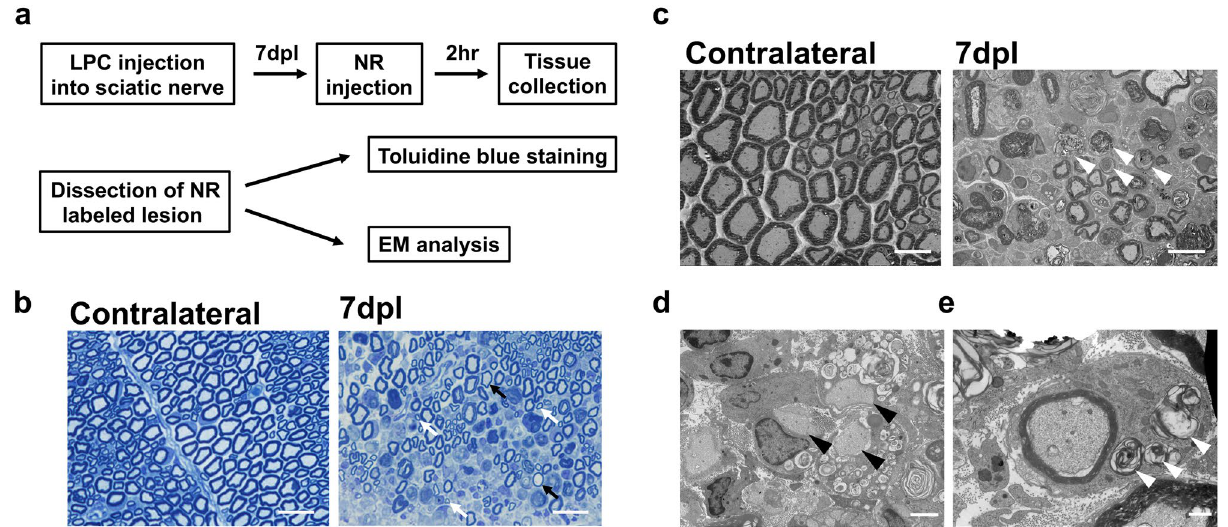
Figure 2. Electron microscopy (EM) analyses following the neutral red labeling. ( a ) Experimental design of EM analyses. Sciatic nerve lesions were induced by lysophosphatidylcholine (LPC) injection and labeled with neutral red (NR) injected 2 h before sacrifice at 7 dpl. Lesions labeled with NR were dissected and embedded in epoxy resin. Semithin sections were stained with toluidine blue. Ultrathin sections were observed by transmission EM. ( b ) Representative images of semithin sections (1 µm) obtained from contralateral and ipsilateral sciatic nerves of the LPC-injected mouse at 7 dpl and stained with toluidine blue. Compared to the contralateral nerve cross-sections, thinner compact myelin ( b , black arrows) and smaller axons ( b , white arrows) with myelin ensheathment were present in the LPC-treated nerve. ( c ) In the EM observation, contralateral axons have thick compact myelin, while myelin debris is observed in ipsilateral sciatic nerve at 7 dpl ( c , white arrowhead). ( d ) Demyelinated axons are observed in the ipsilateral sciatic nerve ( d , black arrowheads). ( e ) A Schwann cell in ipsilateral sciatic nerve contains myelin debris ( e , white arrowheads). N = 2 mice examined. Scale bar, 20 µm ( b ), 10 µm ( c ), 2.5 µm ( d ) and 1 µm ( e